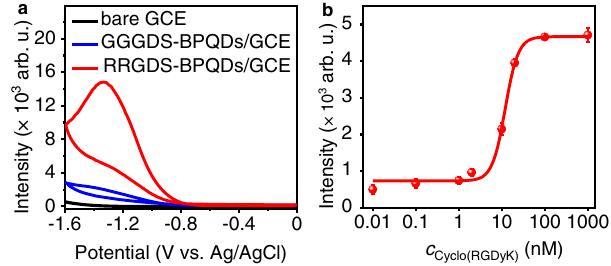
Fig.4|Evaluationofintegrininhibitorcyclo(RGDyK).a ECLcurveswithArg-free peptide (GGGDS-BPQDs/GCE, blue) and Arg-containing peptide (RRGDS-BPQDs/ GCE,red) in 0.1M PBScontaining 0.1M K 2 S 2 O 8 withbareGCE asreference(black). PMT=800V. b ECL response of RRGDS-BPQDs/MWNTs/GCE to 1×10 6 A549 cells mL − 1 pretreated with 0.01, 0.1, 1, 2, 10, 20, 100, and 1000nM cyclo(RGDyK). The error bars represent the SD from 3 measurements. Data are expressed as means±SD. Source data are provided as a Source Data fi le.